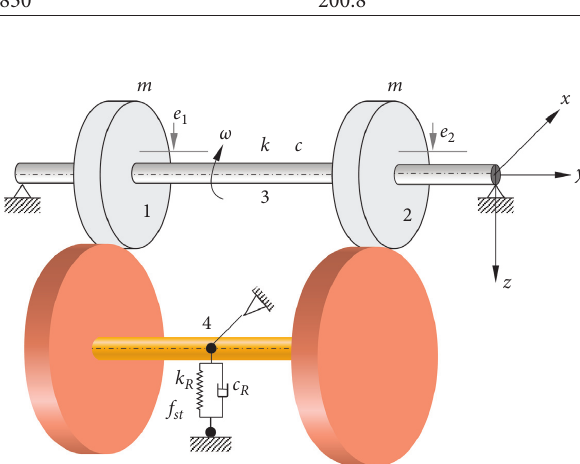
Figure 2: Dynamic model of wheelset rotor system.